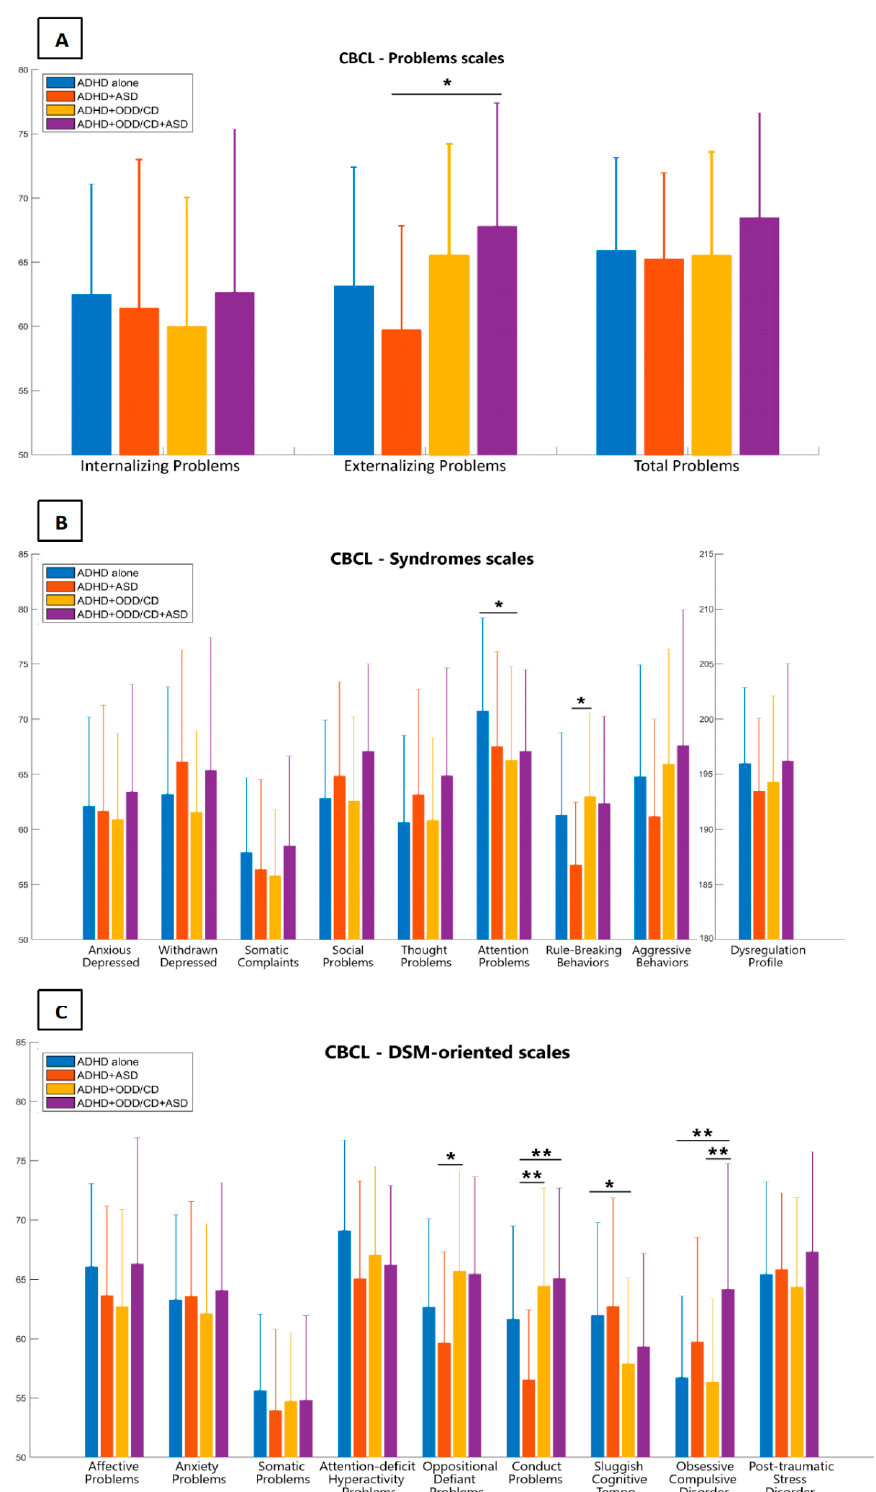
Figure 1. Scores obtained by the four clinical groups in the child behavior checklist questionnaire are illustrated: ( A ) problems scales, ( B ) syndromes scales, and ( C ) DSM-oriented scales are compared between ADHD alone group (blue bars), ADHD + ASD group (red bars), ADHD + ODD / CD group (yellow bars), and ADHD + ASD + ODD / CD group (purple bars). Graphs represent means with standard deviation bars. * p -values < 0.05, ** p -values <